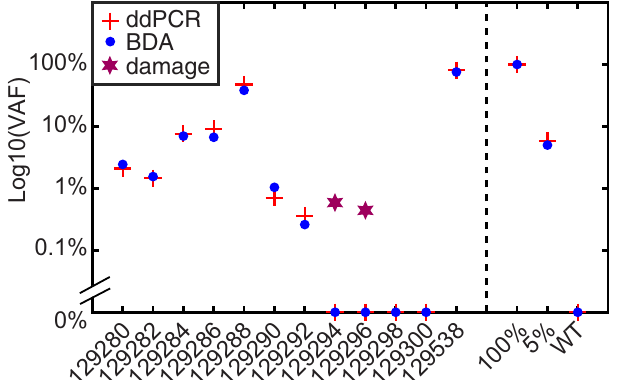
Figure 3. BDA and ddPCR mutation quantitation comparison. “+” symbols refer to ddPCR determined VAF values and blue dots refer to BDA determined VAFs for actionable BRAF mutations. Purple stars refer to FFPE damage profiled by the BDA Sanger assay. The right three samples are reference control samples with BRAF V600E at 100%, 5%, and 0%